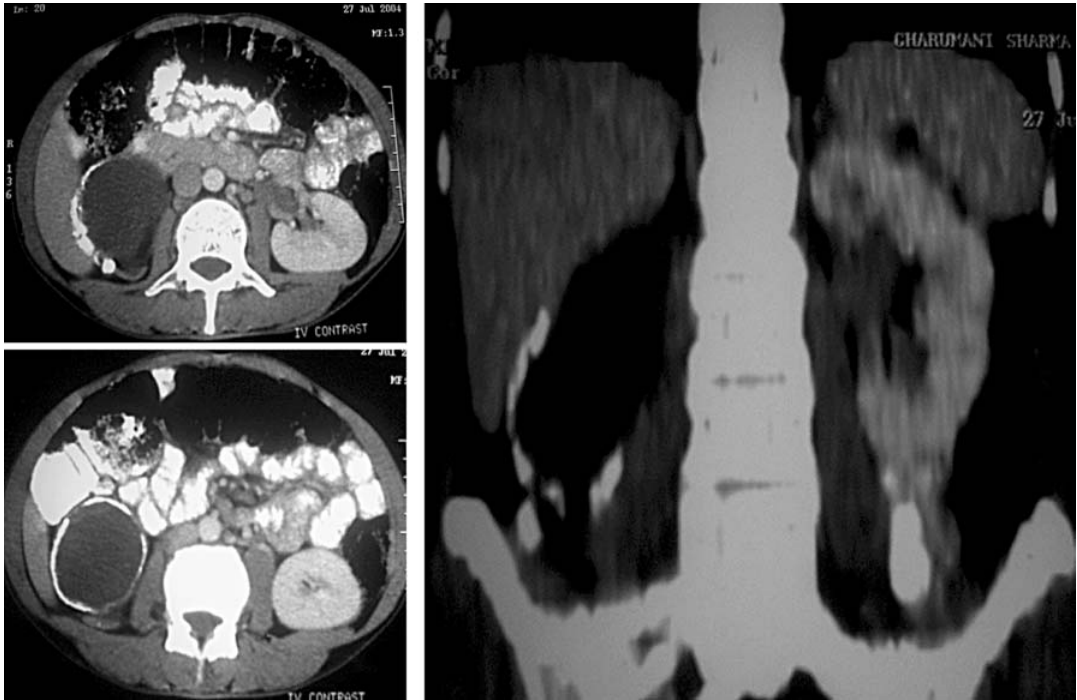
Figure 2 – Computerized tomography showing calcified right hydronephrotic kidney.